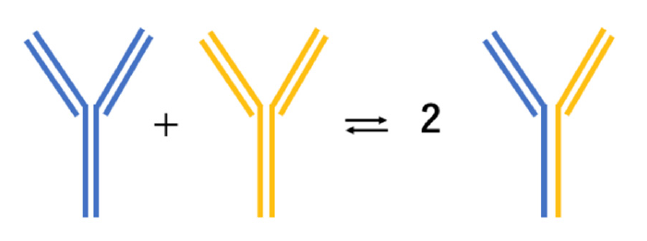
Figure 1. Unique mechanism of IgG4 antibodies becoming bispecific via Fab-arm exchange. To differentiate between AIP and pancreatic cancer, Hamano et al. proposed the use of a cutoff value of 135 mg/dL for serum IgG4 concentrations, which provided a sensitivity of 95% (19/20) and specificity of 97.1% (68/70) [3]. However, Ghazale et al. studied 510 patients, including 45 with AIP, and reported that an elevated serum IgG4 level > 140 mg/dL had a sensitivity of only 75.6% (34/45) and a specificity of 93.1% (433/465). In addition, 9.6% (13/135) of the patients with pancreatic cancer had elevated serum IgG4 levels [16]. IgG4 levels are not useful for the diagnosis of type 2 AIP